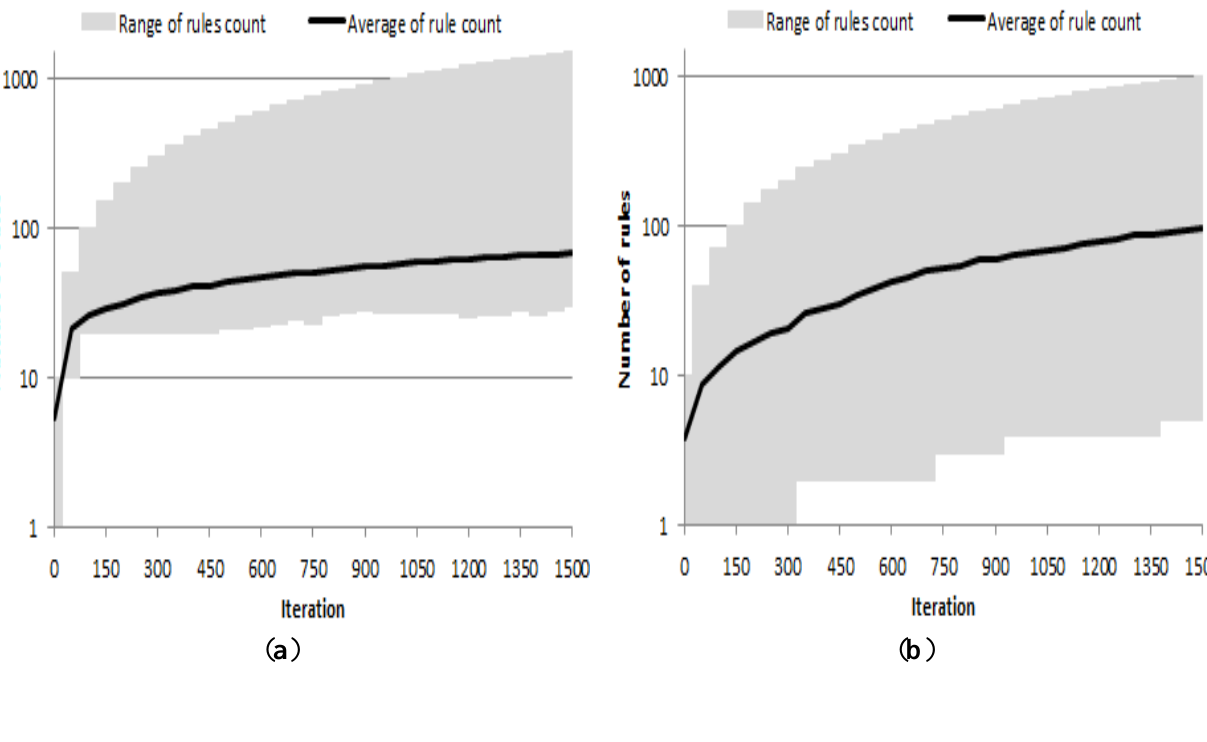
Figure 8. Range of rule count by iteration ranking images using Associative & SFFS method on the ( a ) UCI Statlog Landsat and ( b ) WROX data